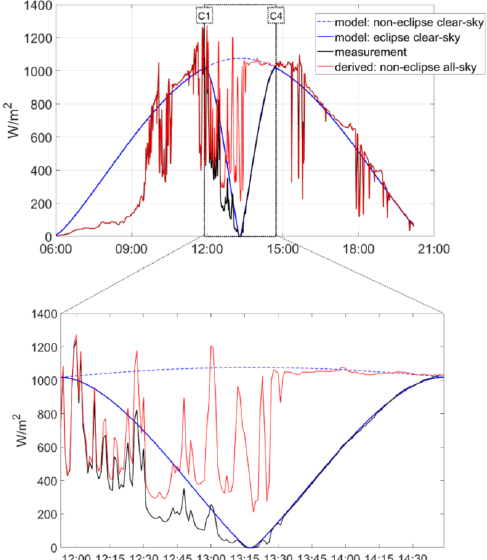
Figure 5: Ground-based GHI measurement (black line), modeled GHI for clear-sky and non-eclipse conditions (dotted line), modeled GHI for clear-sky during the eclipse (blue line) and derive GHI during the eclipse for all-sky conditions (red line). (top) whole day. (bot- tom) partial and total eclipse period C1-C4.